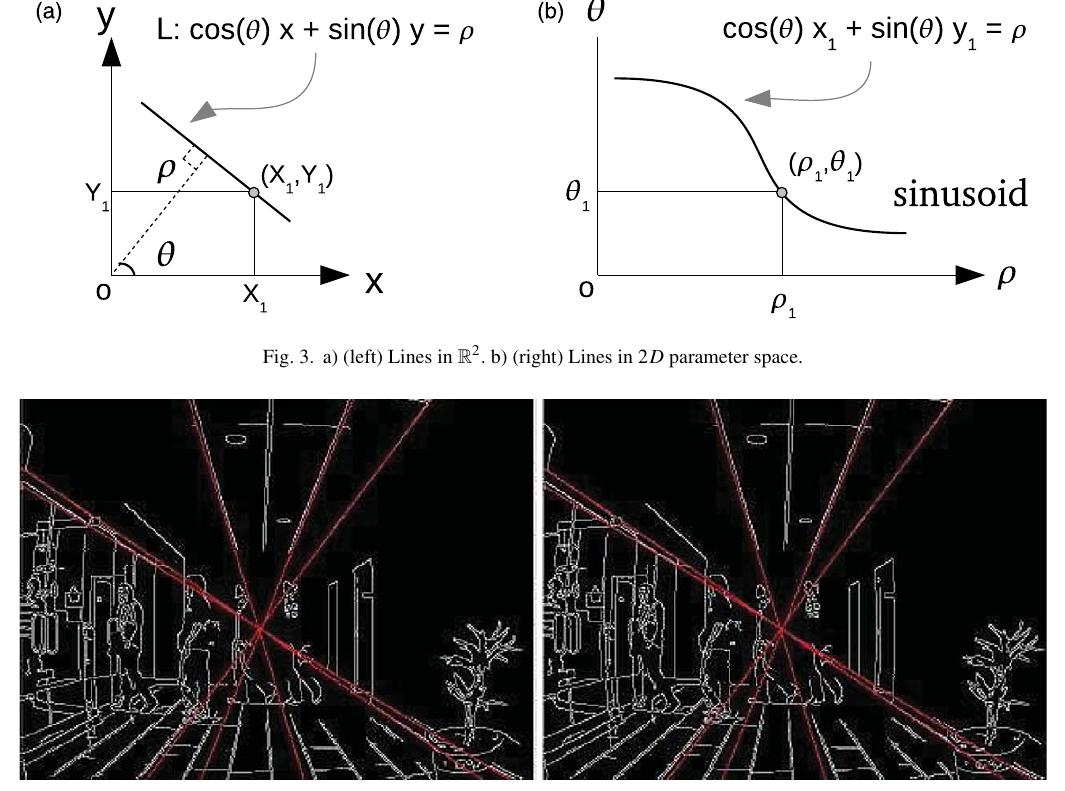
Fig. 4. Detection of vanishing points using lines extracted by the Canny and Hough transform despite the interference of the person’s